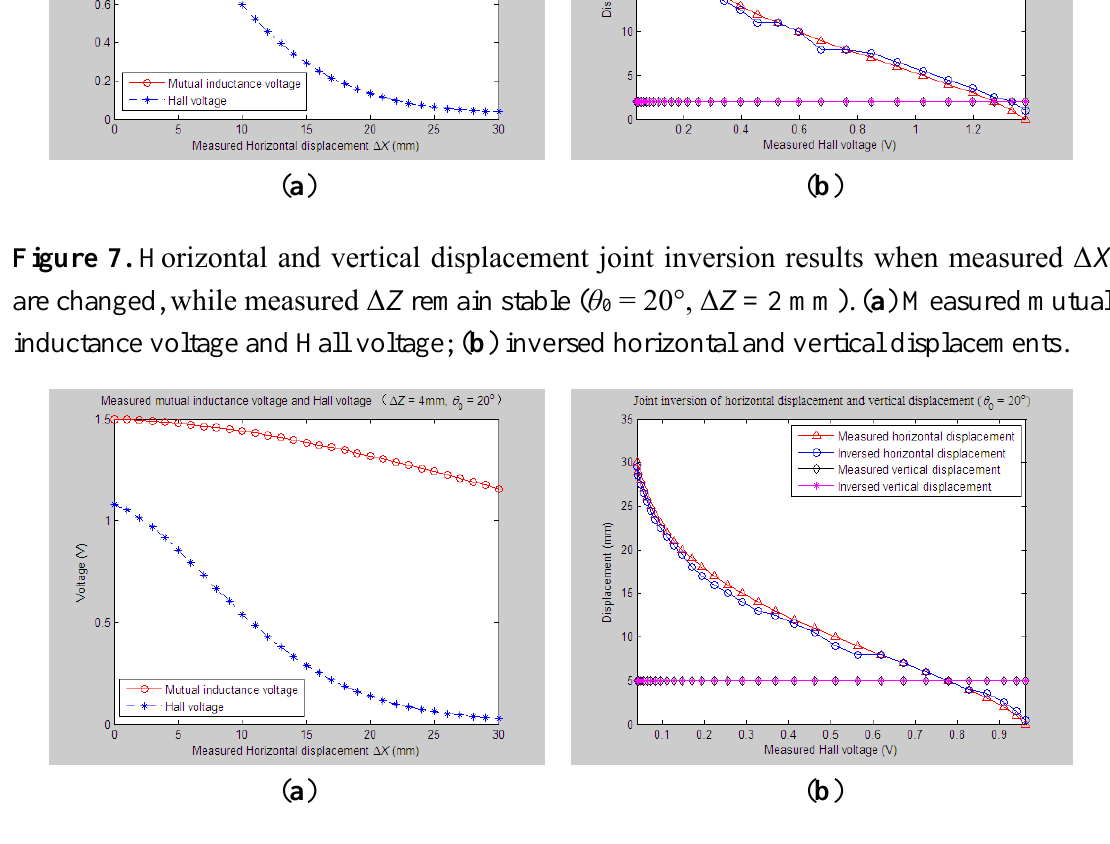
Figure 8. Horizontal and vertical displacement joint inversion results when measured Δ X are changed, while measured Δ Z remain stable ( θ 0 = 20°, Δ Z = 4 mm). ( a ) Measured mutual inductance voltage and Hall voltage; ( b ) inversed horizontal and vertical